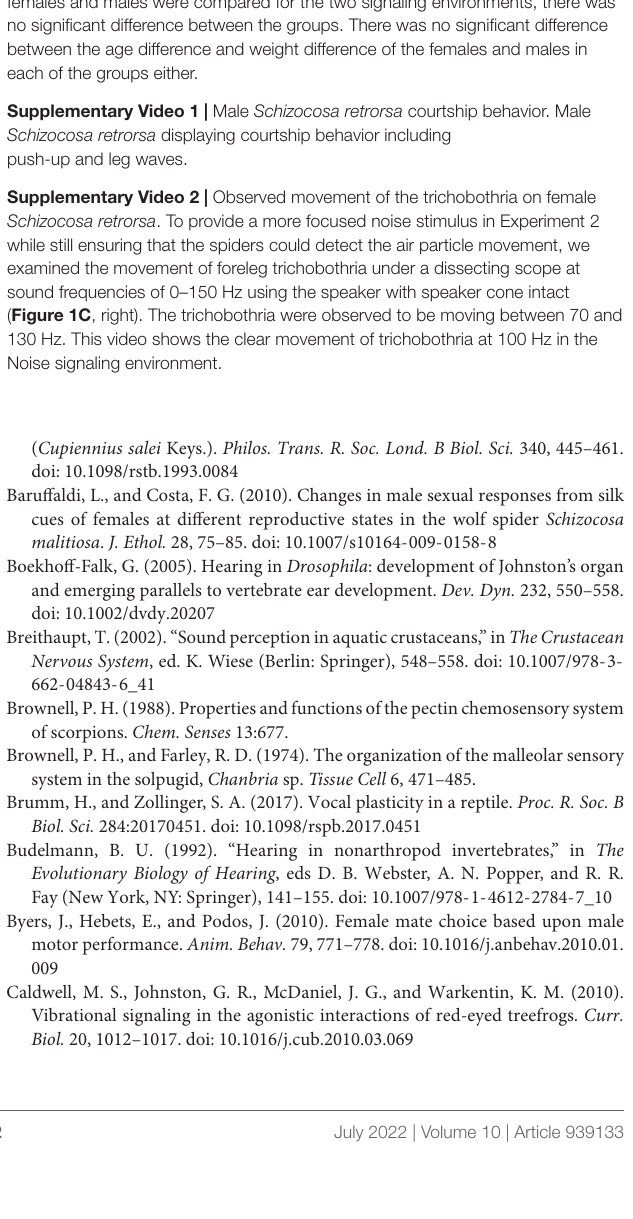
Supplementary Figure 1 | Rate of leg waving bouts and rate of individual leg waves are correlated. There is a strong correlation between the rate of leg waving bouts and rate of individual leg waves ( R = 0.9, p < 2.2e-16). Supplementary Figure 2 | Rate of leg waving bouts and rate of push-ups are correlated. There is a strong relationship between the rate of leg waving bouts and the rate of push-ups ( R = 0.74, p = 5.2e-10). Supplementary Table 1 | Comparison of age and weight of the spiders based on sex and signaling environments for Experiment 1. When the age and weight of females and males were compared for the two signaling environments, there was no significant difference between the groups (weights of two females from each No Noise and Noise groups were missing). There was no significant difference between the age difference and weight difference of the females and males in each of the groups either. Supplementary Table 2 | Comparison of age and weight of the spiders based on sex and signaling environments for Experiment 2. When the age and weight of females and males were compared for the two signaling environments, there was no significant difference between the groups. There was no significant difference between the age difference and weight difference of the females and males in each of the groups